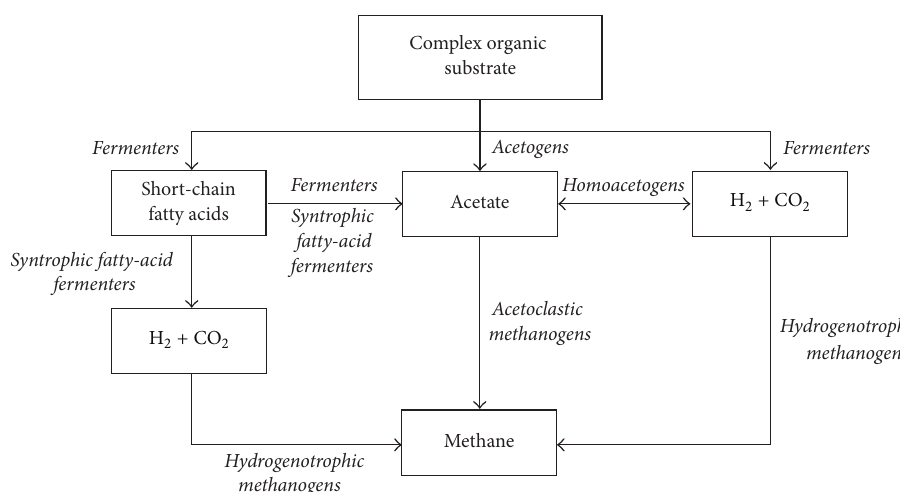
Figure 7: Proposed key anaerobic food-web reactions occurring at ammonia-N concentrations of ∼ 2000 NH 3 -Nmg L −1